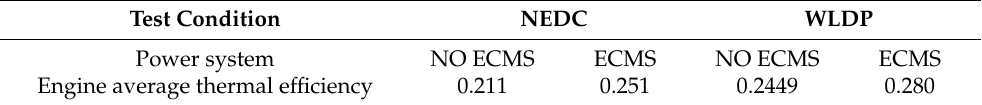
Figure 15. Comparison of engine thermal efficiency in two − power system under WLTP condition. Table 4. Comparison of fuel consumption under various power systems.